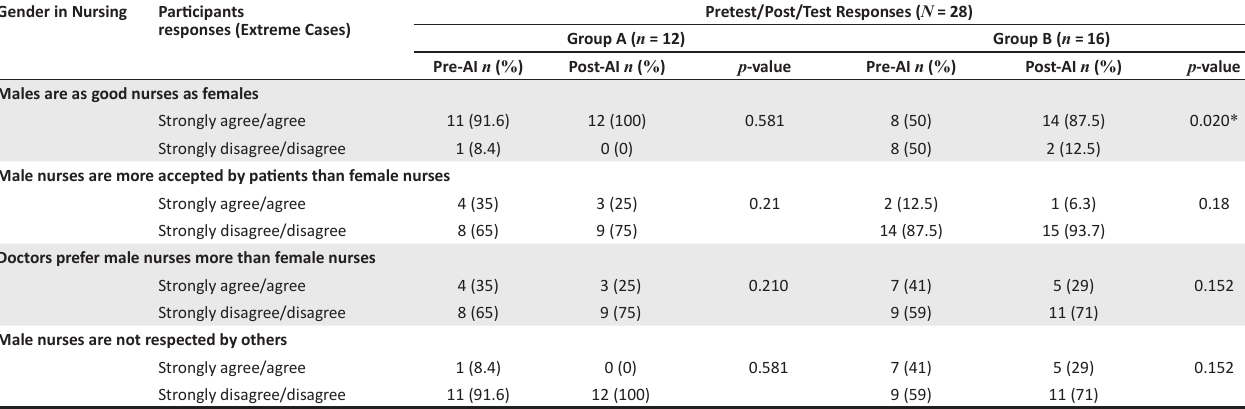
TABLE 4: Student nurses’ perceptions of gender in nursing before and after appreciative inquiry intervention. Gender in Nursing Participants responses (Extreme